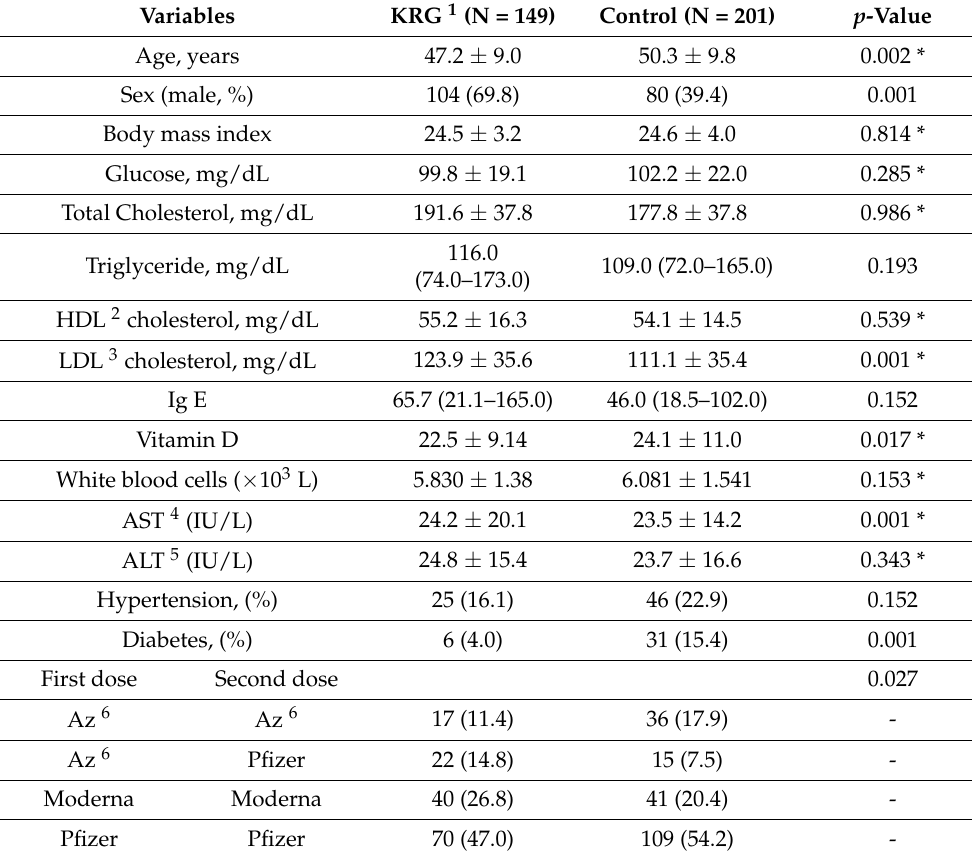
Table 1. Baseline characteristics * of the study population according to KRG